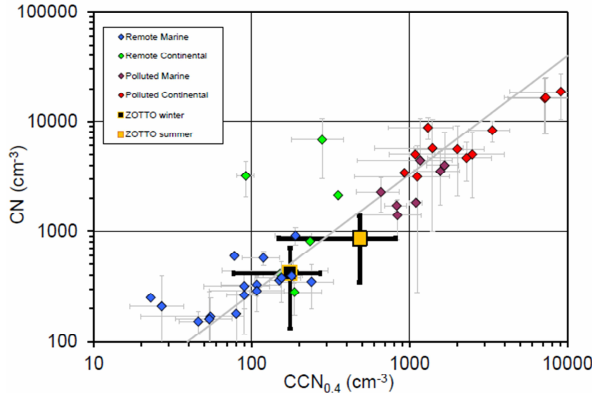
Figure 10: ZOTTO aerosol number concentratins in global context, based on Andreae (2009). Fig. 10. ZOTTO aerosol number concentrations in global context, based on Andreae